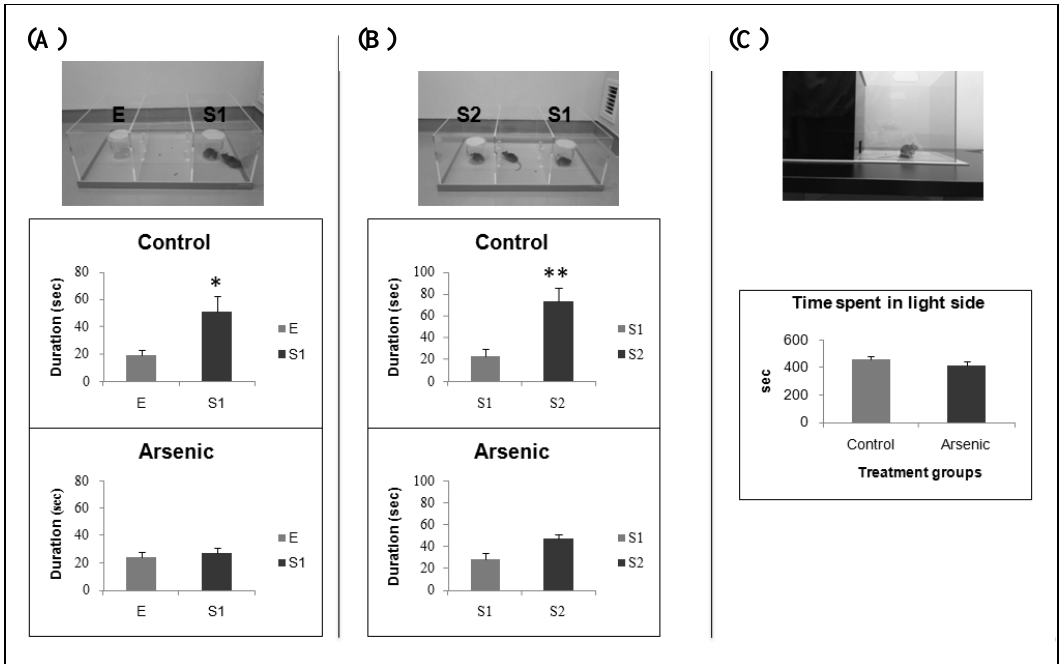
Figure 1. Effect of developmental arsenic exposure on social behavior: ( A ) Sociability test, ( B ) Social novelty preference test, and ( C ) Light-dark transition test in the control group and the arsenic-exposed group of 74-week-old male mice. Each bar represents the mean ± SE (n = 14, * p < 0.05, ** p < 0.001). E, empty; S1, stranger 1; S2, stranger 2.